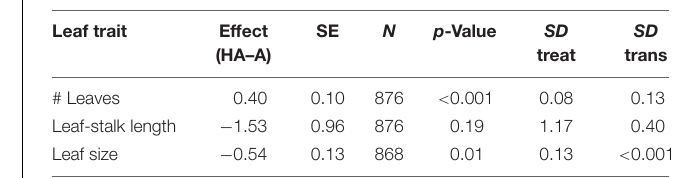
TABLE 2 | Differences in leaf traits between the high alpine (HA) and the alpine (A)